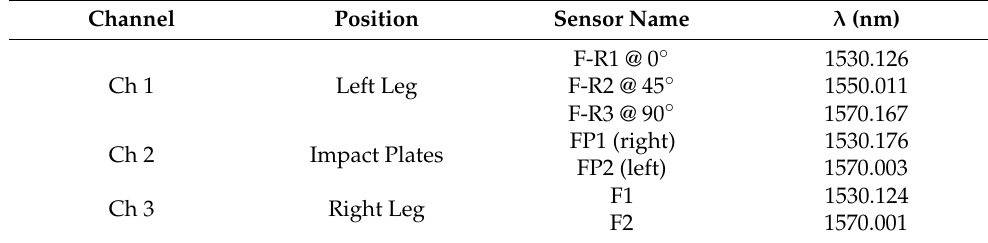
Table 1. FBGs arrays’ configurations.